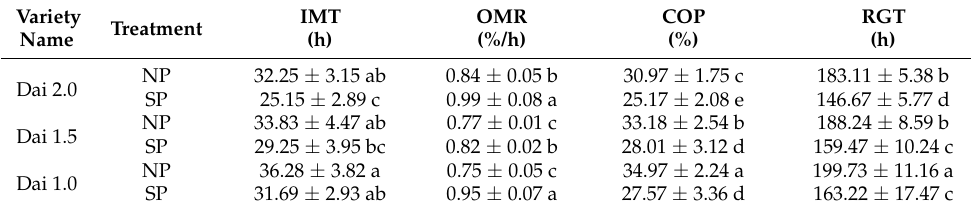
Table 3. Effect of sand priming on seed respiration of Pinus massoniana